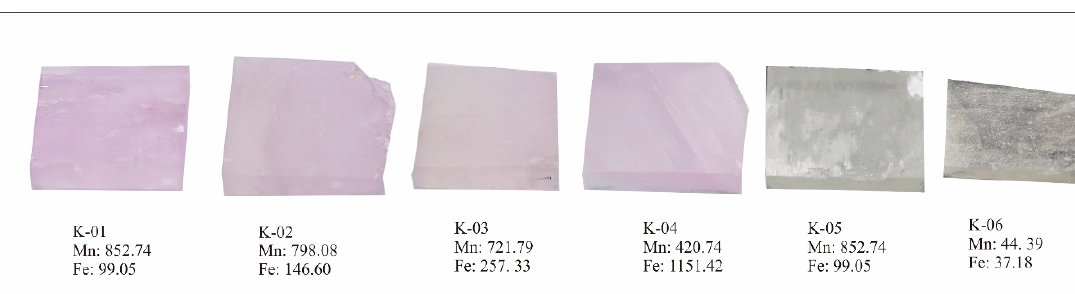
Figure 2. ( A ) Photograph of the kunzite crystals before cutting, ( B ) photograph of the 21 cut kunzite crystals.